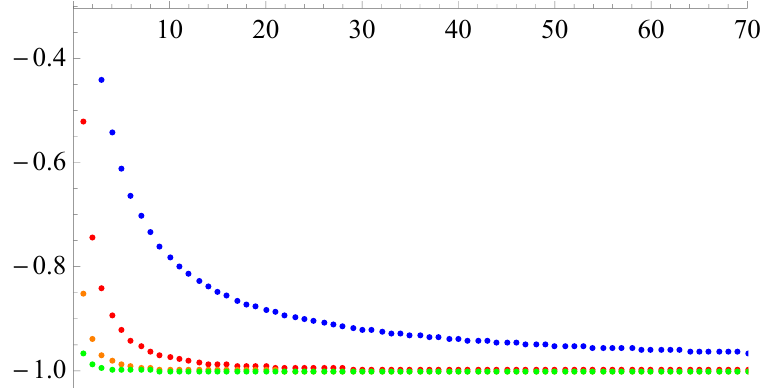
of the large gQ expansion b n − 1